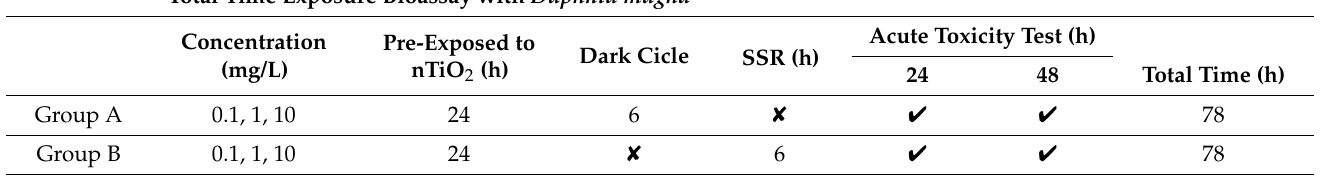
Table 1. Total time of the preliminary bioassay, counting the first doping 24 h, plus 6 h of the dark cycle and radiation, plus the acute toxicity test time 24 and 48 h, resulting 78 h total.